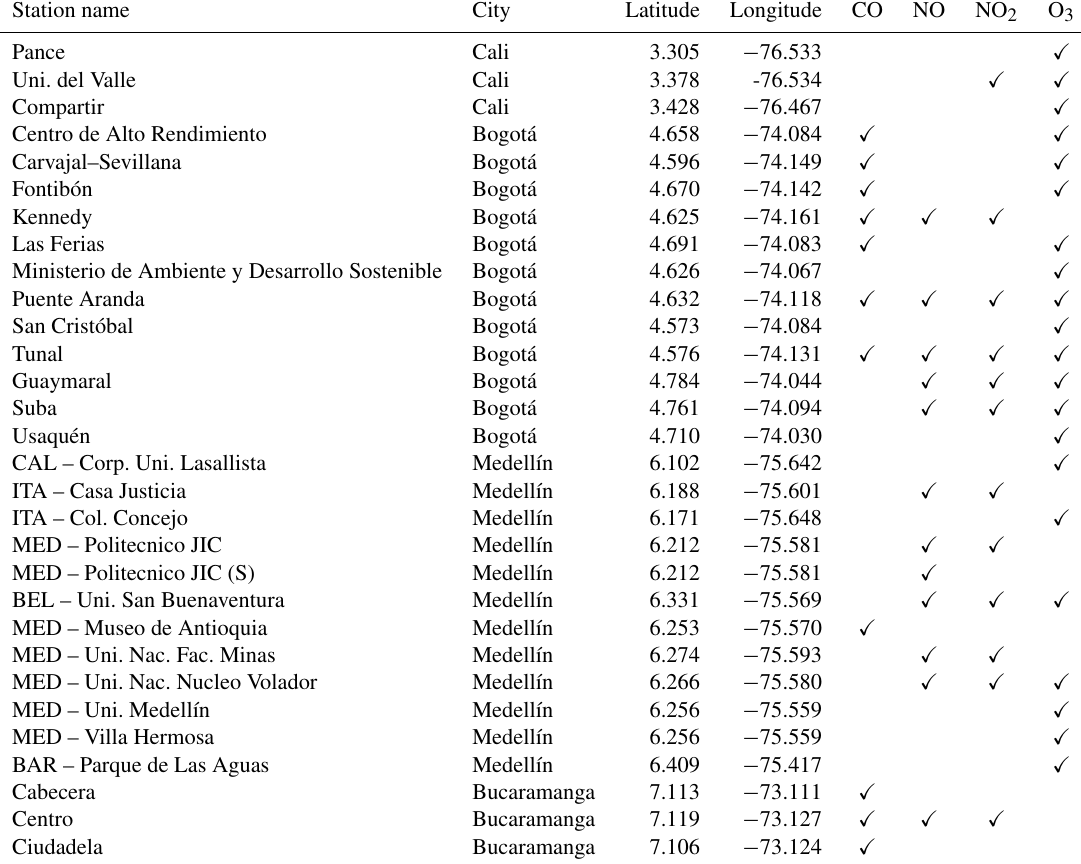
Table A1. Available air quality monitoring stations including city, location and measured compounds. Note that JIC – Jaime Isaza Cadavid and S – semiautomatic